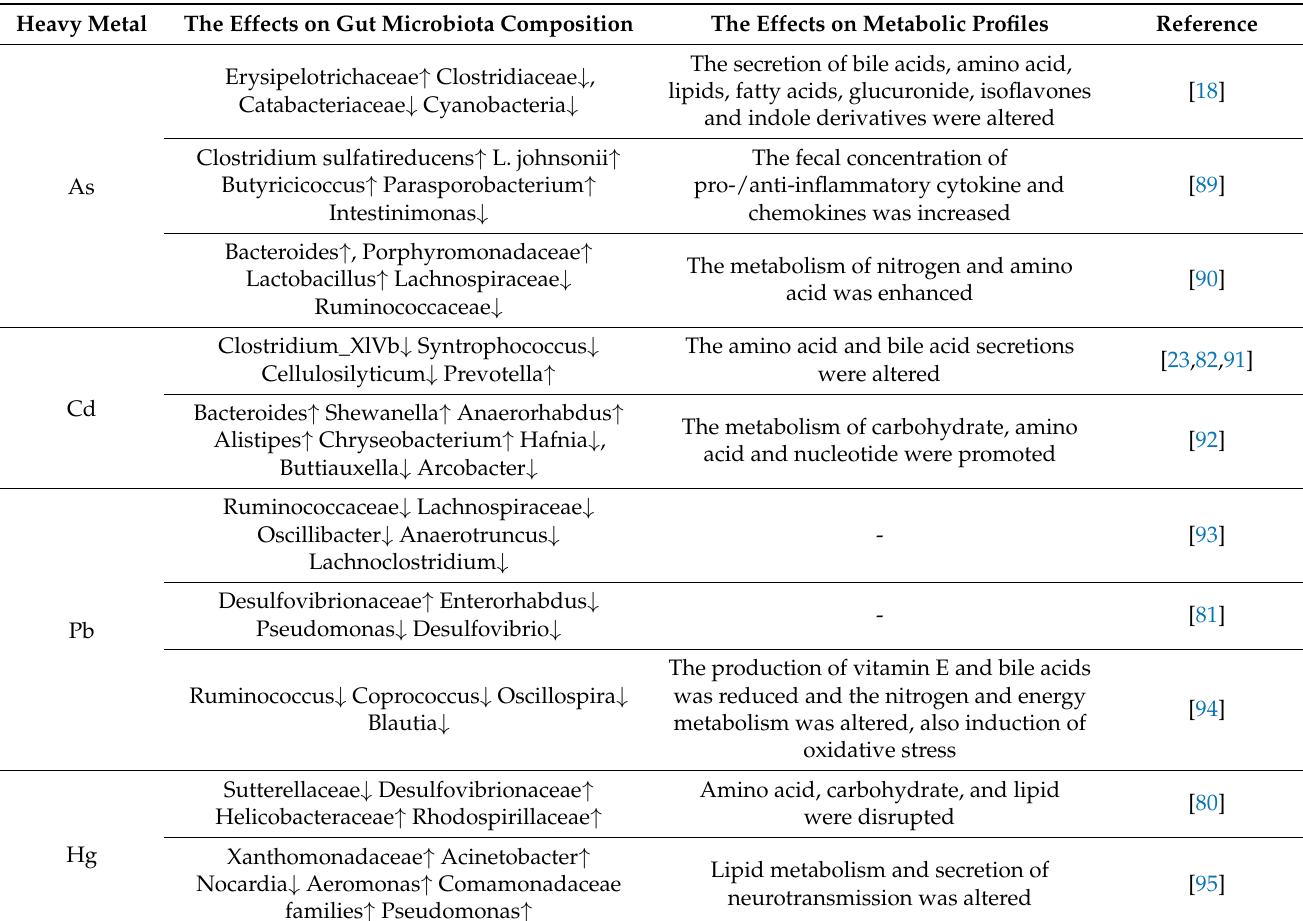
Table 1. The HM-induced changes in gut microbiota composition and metabolic